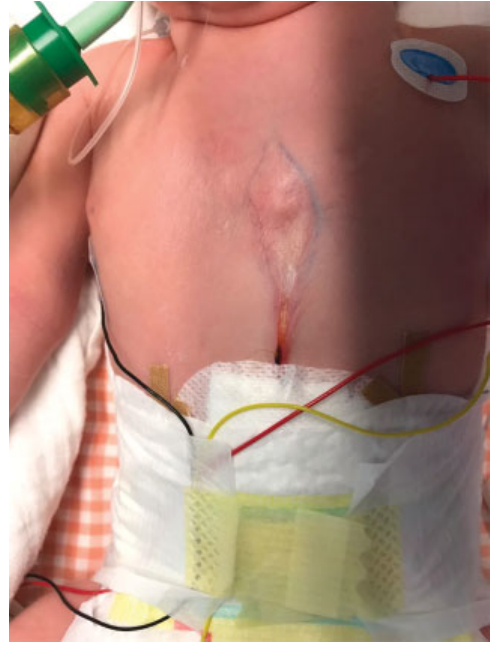
Fig.2 IntraoperativesituswithautologousgraftintheupperpartoftheSC ( cranial, thymus, sternum, $ autologous